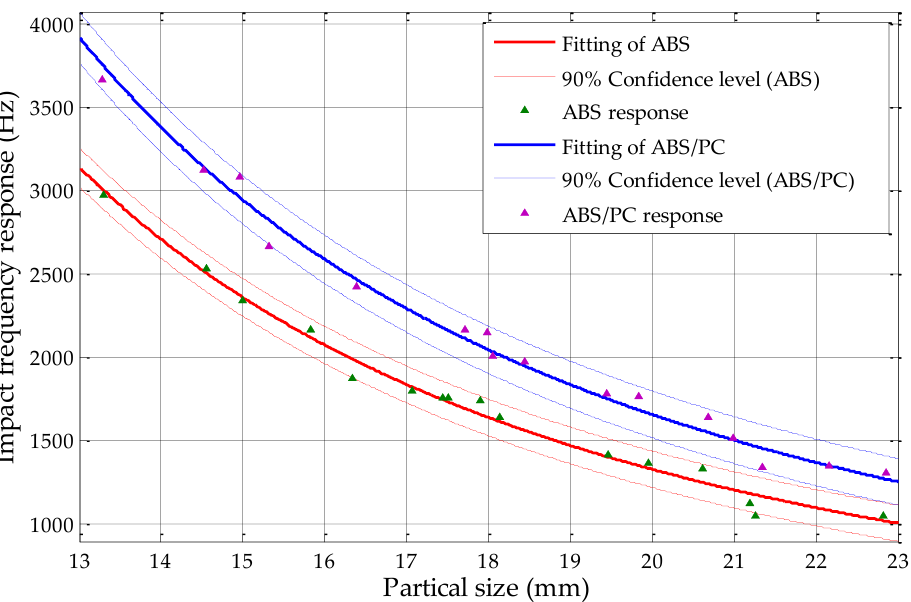
Figure 17. The 90% confidence level of the ABS and ABS/PC mixture by using circularity measurements.